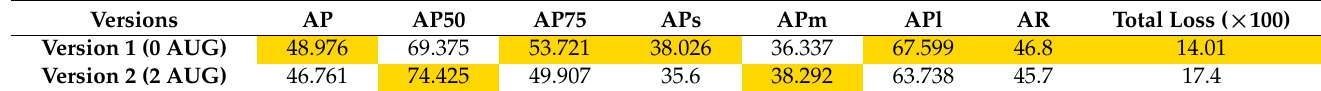
Table 15. Detectron2 metrics obtained with the first model. Each column refers to a different metric, as defined in Section 2.4.2. Each row refers to a different version of the